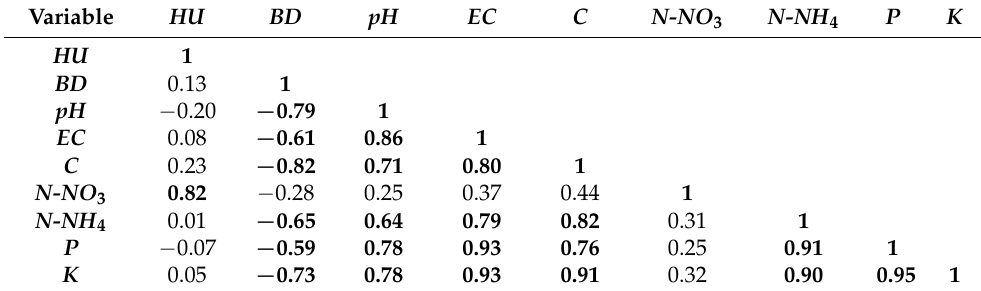
carbon concentration; ( N-NO 3 ) soluble nitrate nitrogen concentration; ( N-NH 4 ) soluble ammonium nitrogen concentration; ( P ) soluble phosphorus concentration; ( K ) soluble potassium concentration; significant values of factor loadings are highlighted in bold.